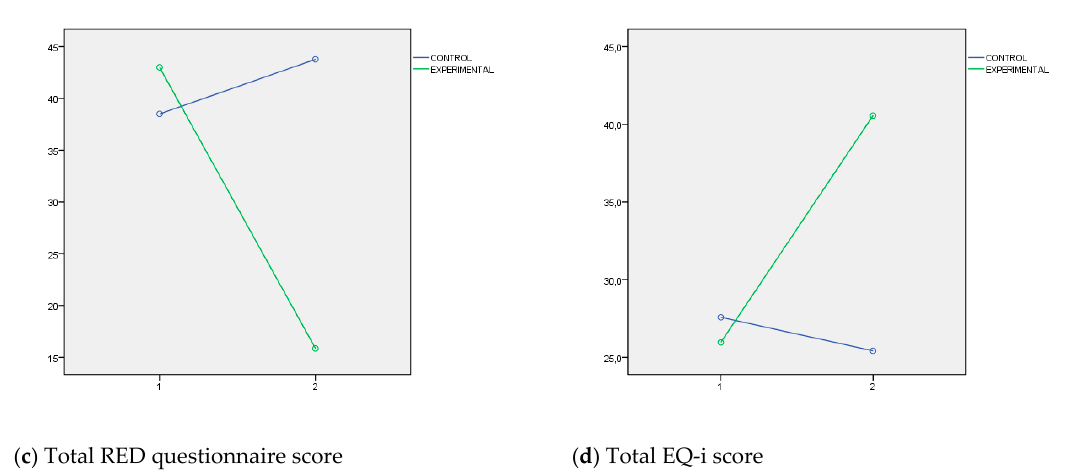
Figure 1. Estimated marginal means for ( a1 ) total PSQ scores and ( a2 ) total PSS scores (stress levels); ( b1 ) Emotional exhaustion scores, ( b2 ) Depersonalization scores, and ( b3 ) Personal accomplishment scores on the MBI (burnout levels); ( c ) total RED questionnaire scores (ICT competency); and ( d ) total EQ-i scores (EI competency).